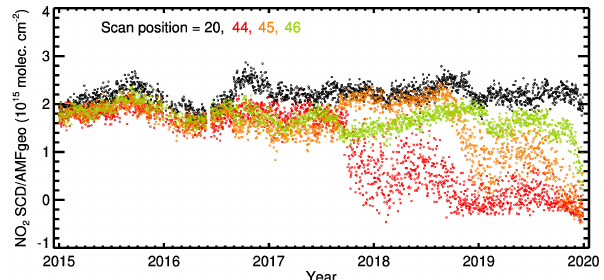
Figure 7. The time series of OMI NO 2 SCD normalized by the geometric AMF for clear-sky and partially cloudy conditions (CRF < 0.5) over the Pacific Ocean. The data are separated by cross-track scan position, comparing the presumably RA-free row 20 (black) with rows 44 (red), 45 (orange), and 46 (green). The row numbers are